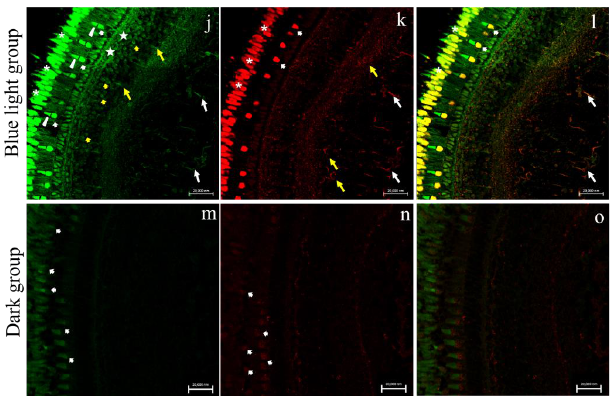
Figure 2. Calbindin-D28K/Calretinin-N18 immunostaining in zebrafish ( Danio rerio ) retina, approxi- mately 4-months-old. ( a – c ) Calbindin-D28K/Calretinin-N18 immunostaining in control group (natural photoperiod conditions) ( a ) CaB-D28K-immunoreactivity in the cytoplasmic prolongations of the cells of the retinal pigment epithelium (RPE) (chevron arrows), in the cones and rods of the photoreceptors layer (bold arrows). ( b ) CaR-N18 immunoreactivity in the outer plexiform layer (OPL) (asterisks), in the soma of a subpopulation of amacrine cells (arrowheads) and bipolar cells (arrows), in the inner plexi- form layer (IPL) (stars), and in the soma of ganglion cells (GCs) (yellow arrows). ( c ) Merge: absence of Calbindin-D28K/Calretinin-N18 colocalization. ( d – f ) Calbindin-D28K/Calretinin-N18 immunostaining in white light group (emission 34.8% of 400–500 nm). ( d ) CaB-D28K-immunoreactivity in the cytoplasmic prolongations of the cells of the retinal pigment epithelium (RPE) (chevron arrows), in the outer segments of cones (bold arrows), and inner segment of cones (yellow arrowheads) and in the rods (yellow bold arrows), in the outer plexiform layer (OPL) (arrows), in the bipolar cells (yellow arrows), in the inner plexiform layer (IPL) (stars), and in the ganglion cells and their axons (GC) (asterisks). ( e ) Calretinin-N18 immunoreactivity in the inner segments of cones (bold arrows), in the rods (arrows), in the innermost layer of the OPL (yellow arrows), in the innermost layer of the IPL (stars) and in the GCs and their axons (asterisks). ( f ) Merge: Calbindin-D28K/Calretinin-N18 colocalization in inner segments of cones (bold arrows), in the rods (arrows), in the innermost layer of IPL (stars) and OPL (yellow arrows) and in the GCs and their axons (asterisks). ( g – i ) Calbindin-D28K/Calretinin-N18 immunostaining in white–blue light group (emission 54.6% of 400–500 nm). ( g ) Calbindin-D28K immunoreactivity in retinal pigment epithelium (RPE) into the cytoplasmic prolongations of its cells (chevron arrow), in the inner (bold arrows) and outer segment of cones (arrows heads), in the rods (yellow bold arrows), in the innermost layer of OPL (arrows), in the bipolar cells (yellow arrows) and in the IPL (stars). ( h ) Calretinin-N18 immunoreac- tivity in the inner segments of cones (bold arrows), in the rods (yellow bold arrows), in the innermost layer of OPL (arrows), in the BCs (yellow arrows), in a subpopulation of amacrine cells (arrowheads), in the innermost layer of OPL (stars), and in the GCs (asterisk). ( i ) Merge: Calbindin-D28K/Calretinin-N18 colocalization in the photoreceptor layer (bold arrows), in the innermost layer of OPL (arrows), in the BCs (yellow arrows) and in the innermost layer of IPL (stars). ( j – l ) Calbindin-D28K/Calretinin-N18 immunostaining in blue light group (emission 84.3% of 400–500 nm). ( m ) Calbindin-D28K immunore- activity in the outer (arrowheads) and inner (bold arrows) segment of cones and in the rods (asterisks), in the OPL (stars), in some amacrine cells (yellow bold arrows), in the BCs (yellow arrows), and GCs (arrows). ( n ) Calretinin-N18 immunoreactivity in the inner segments of cones (bold arrows) and rods (asterisks), in a subpopulation of amacrine cells (yellow arrows), GCs, and their axons (arrows). ( o ) Merge: Calbindin-D28K/Calretinin-N18 colocalization in the inner segments of cones (bold arrows) and in the rods (asterisks) and in some GCs and their axons (arrows). ( m – o ) Sample kept in dark conditions. ( m ) Low CaB-D28K immunoreactivity and ( n ) low CaR-N18 immunoreactivity in the photoreceptors layer. No immunostaining to Calbindin-D28K ( a ) and Calretinin-N18 ( b ) in the other retinal layers. ( o ) Merge: no immunostaining to Calbindin-D28K/Calretinin-N18. Magnification 40 × ( a – o